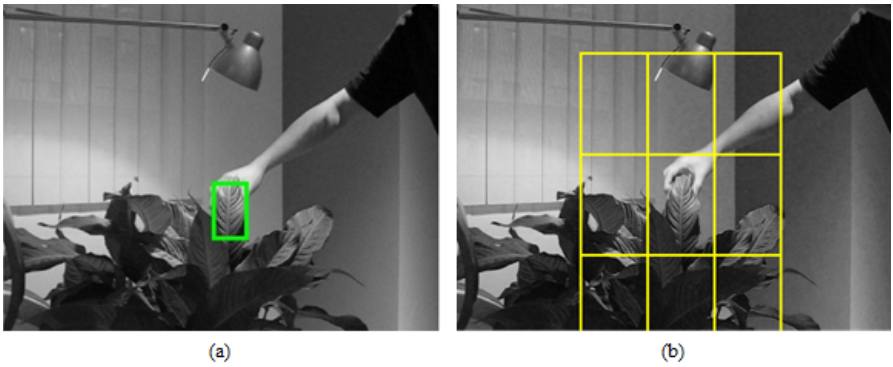
Figure 5. ( a ) Tracking failure detected as the target disappeared. ( b ) Multiple search windows are deployed in tracking failure handling process.